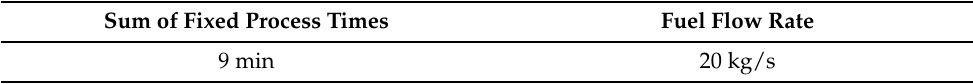
Table 8. Calculation basis for refueling with liquid hydrogen by [59].